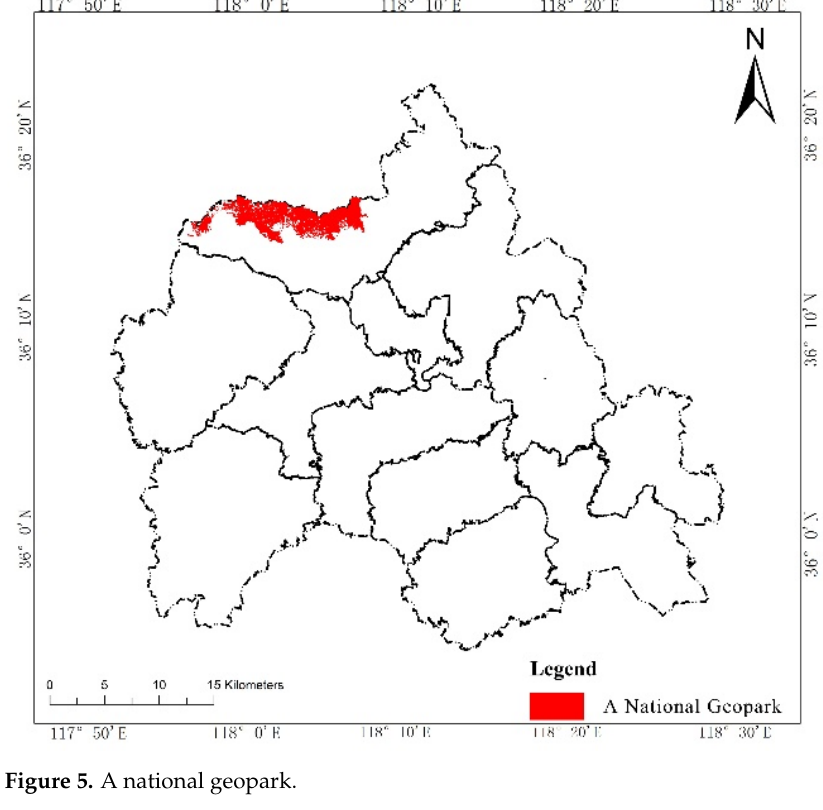
Figure 4. Comprehensive evaluation of ecological protection.